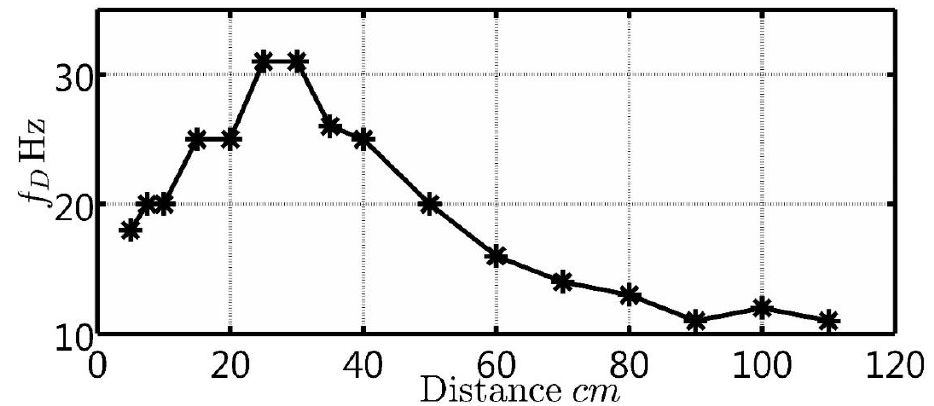
Figure 5. Dark frequency versus link distance.